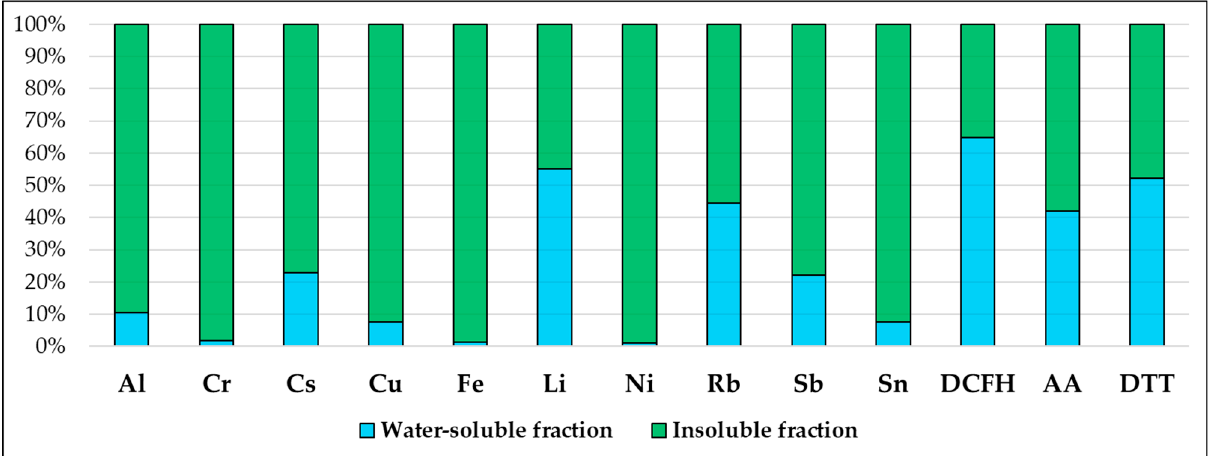
Figure 1. Average solubility percentages (%) of the elements in the 20 PM 10 samples collected at PR and average contribution percentages (%) of the two solubility fractions to the TOP DCFH , TOP AA , and TOP DTT .